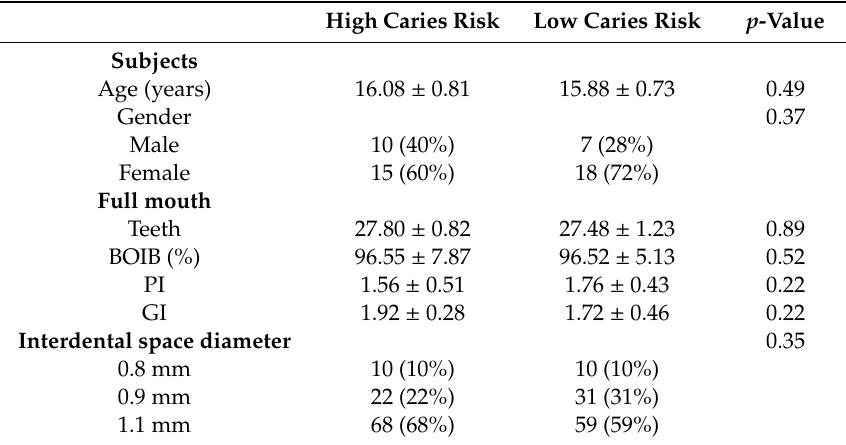
The values are mean ± standard deviation, the numbers and percentages of subjects are indicated. BOIB: Bleeding On Interdental Brushing, GI: Gingival Index, PI: Plaque Index. Table 3. Description (mean ± sd) of bacterial counts (log 10 x + 1) in 200 quadrants ( n = 50 patients × 4 quadrants / patient) and comparison according to caries risk.